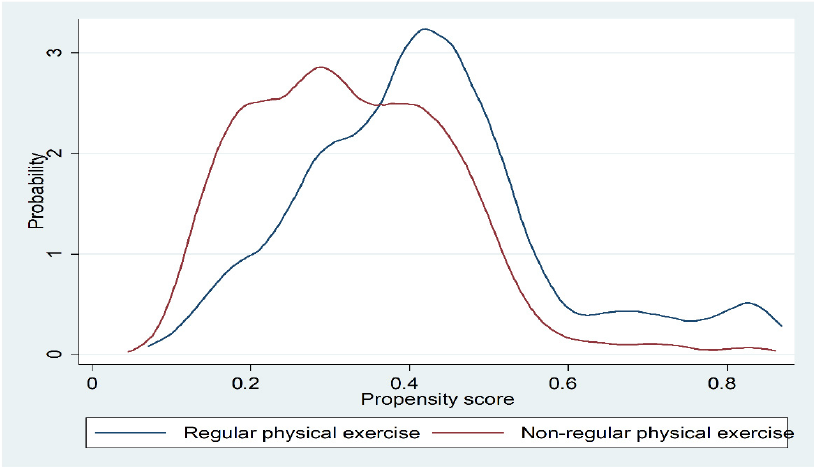
Figure 2. Propensity score distribution with regards to regular participation in physical exercise.